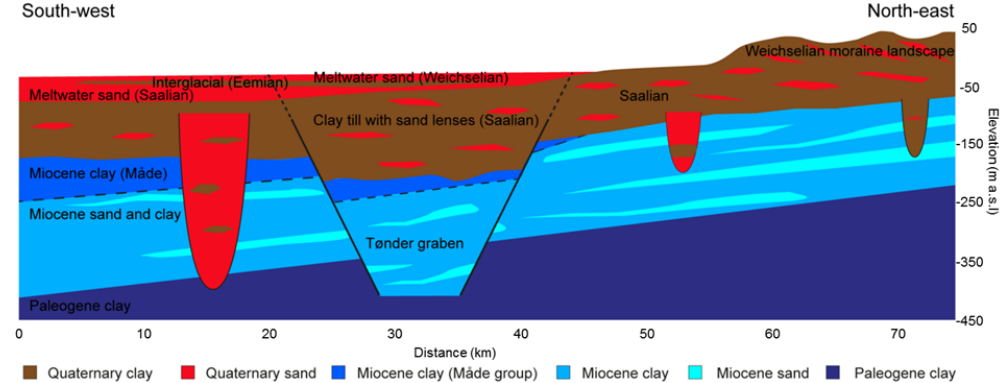
Figure 3. Conceptual sketch of the geology in the study